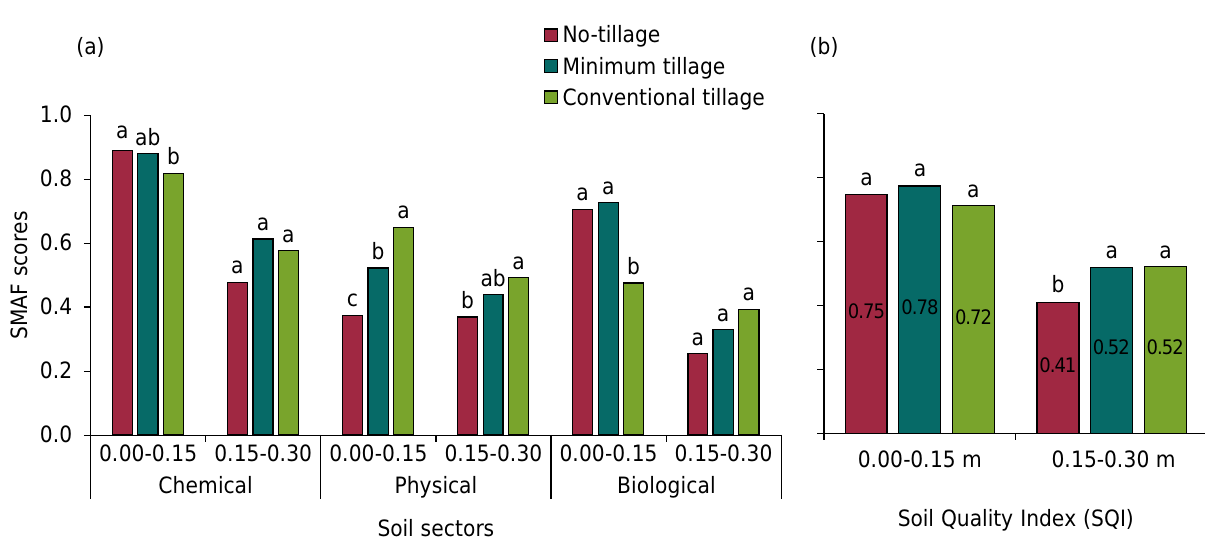
Figure 3. Soil sectors (chemical, physical, and biological) (a) and overall Soil Quality Index (SQI) (b) for the 0.00-0.15 and 0.15-0.30 m layers in a cassava production area under different tillage systems. Mean scores within each depth and sector or SQI followed by the same letter do not differ among themselves according to Tukey’s test